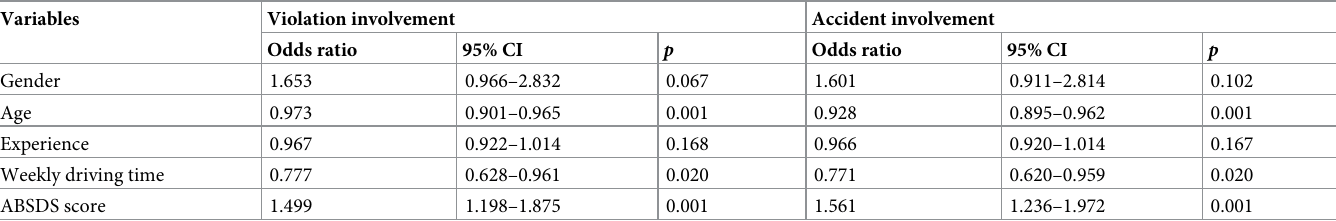
Table 6. Predictive role of ABSDS score on accident involvement.